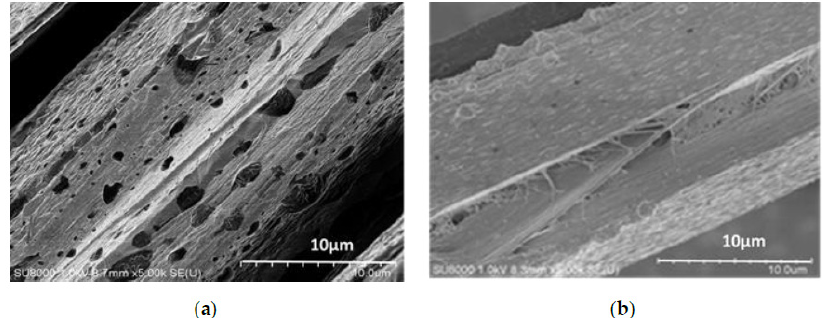
Figure 4. SEM images of the Kevlar 49 fibers etched by 85% H 2 SO 4 ( a ) as received ( b ) treated in scCO 2 with TDI under tension.